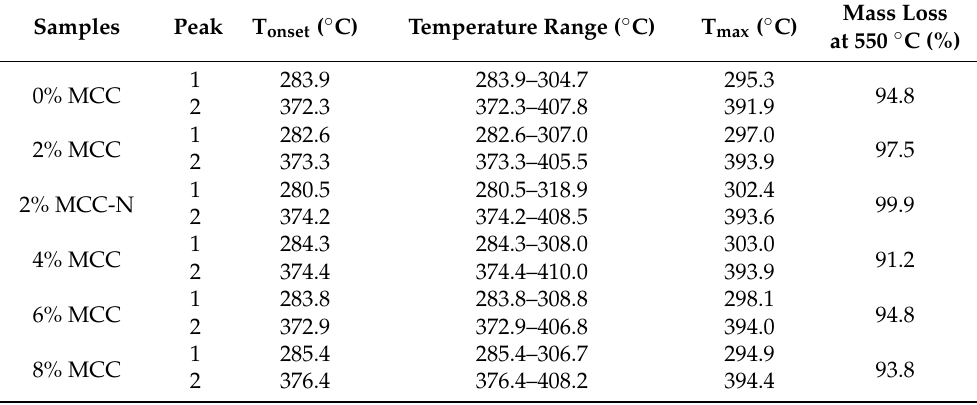
Figure 4. FT-IR spectra of PBAT/TPS/MCC composites. Table 3. The parameters of the thermogravimetric analysis of PBAT/TPS/MCC